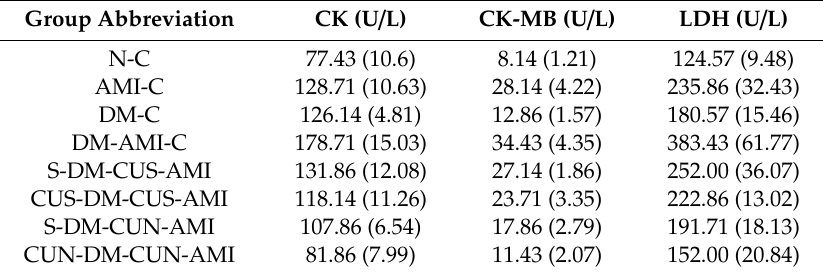
Table 3. Serum levels of myocardial infarction enzymes.